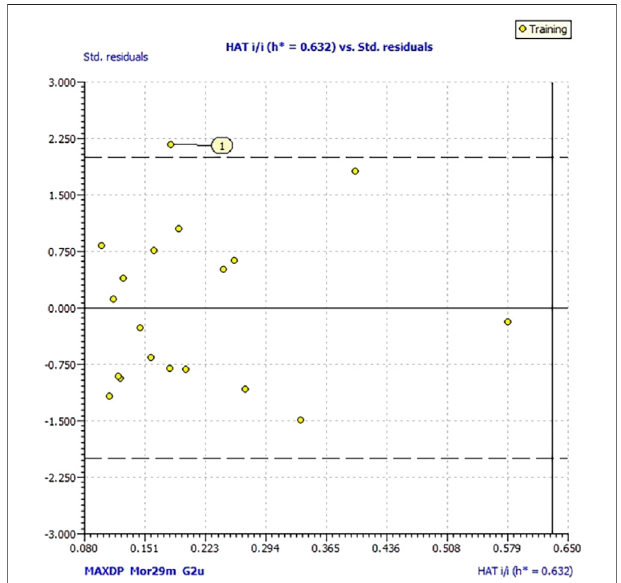
FIGURE 3 | Williams plot of applicability domain of the QSAR model